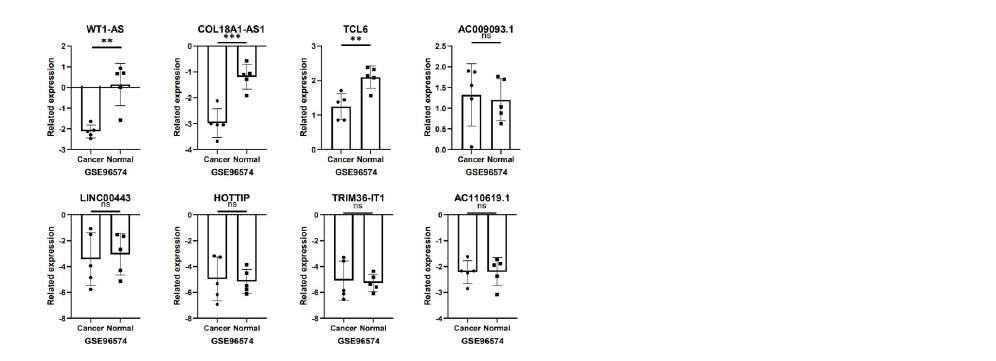
Fig 8. In the independent dataset GSE96574, the eight lncRNAs selected were verified. NS: no significance.